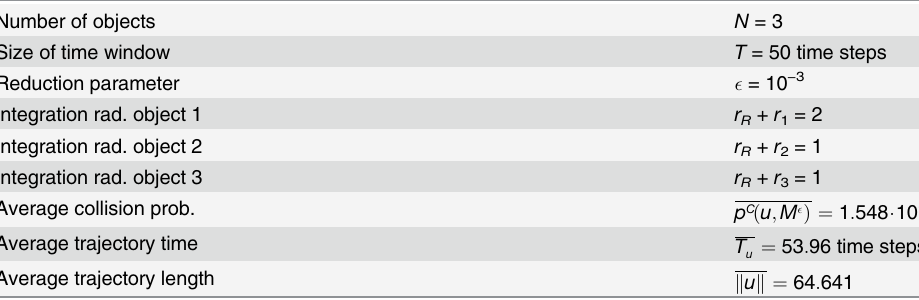
Table 2. Simulation results and parameter